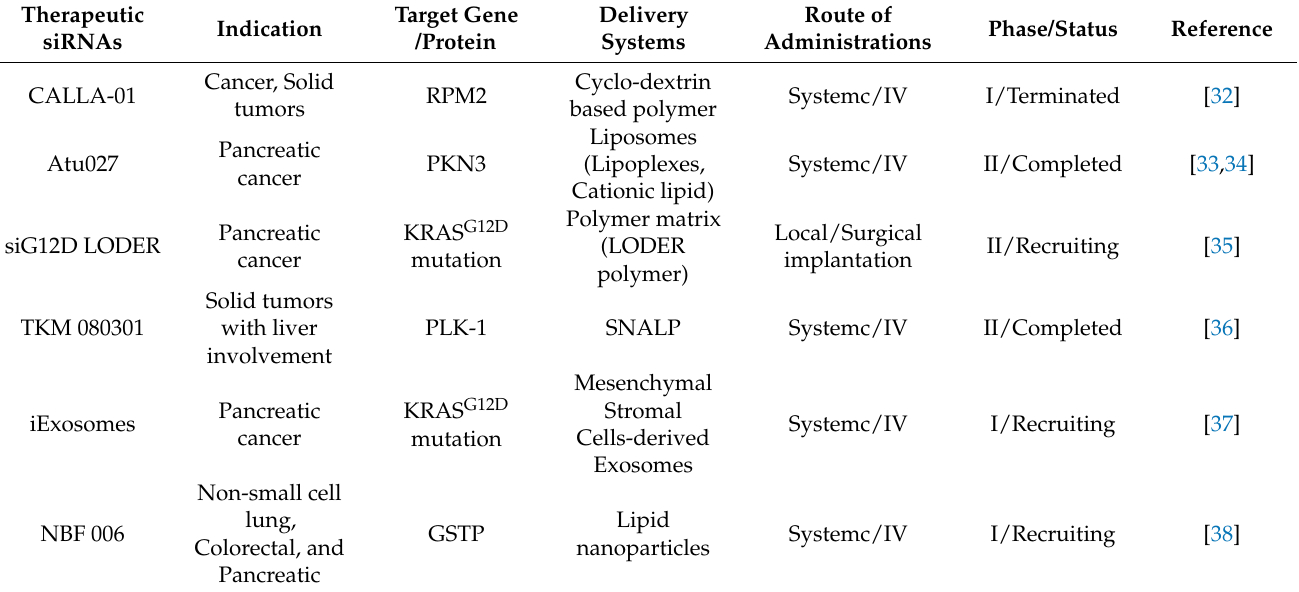
Table 1. Nanocarriers-based siRNA therapeutics in clinical trials for the treatment of pancreatic